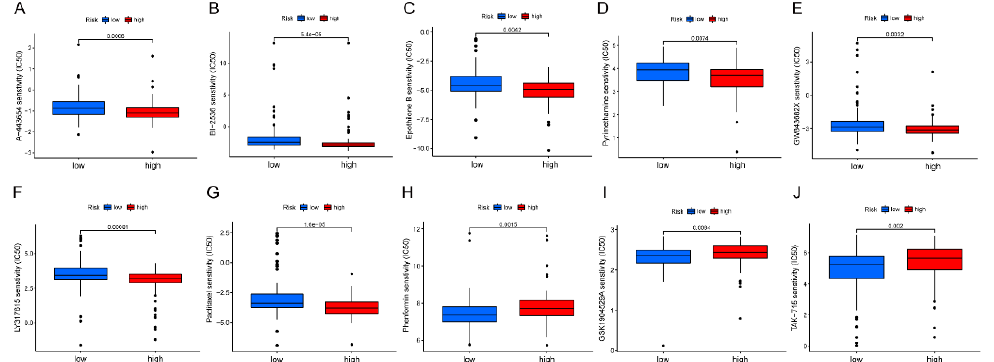
Figure 9. Correlation of Risk Prognostic Signature and Chemotherapy Drug Sensitivity. ( A – J ) Differences in sensitivity (IC50) for 10 common chemical drugs between high- and low-risk groups.